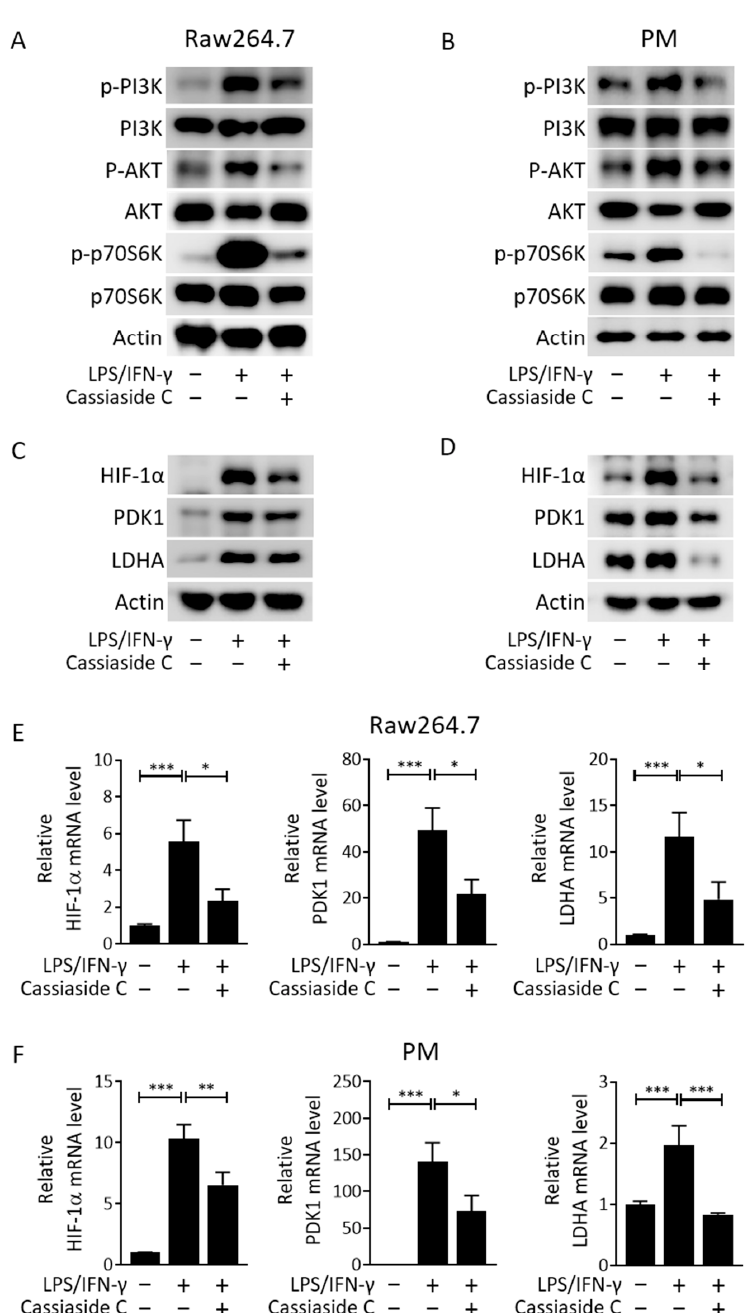
Figure 3. Cassiaside C attenuates LPS/IFN- γ -stimulated mTORC1 activity and the glycolytic pathway. ( A , B ) Effects of Cassiaside C on phosphorylated PI3K, AKT, and p70S6K in LPS/IFN- γ -stimulated Raw264.7 cells and PMs. ( C – F ) Effects of Cassiaside C on HIF-1 α , PDK1, and LDHA protein levels ( C , D ) and mRNA expression ( E , F ) in LPS/IFN- γ -stimulated Raw264.7 cells and PMs. Data are expressed as the mean ± SEM ( n = 3 technical replicates). * p < 0.05, ** p < 0.01, and *** p < 0.001. PM, peritoneal macrophages.